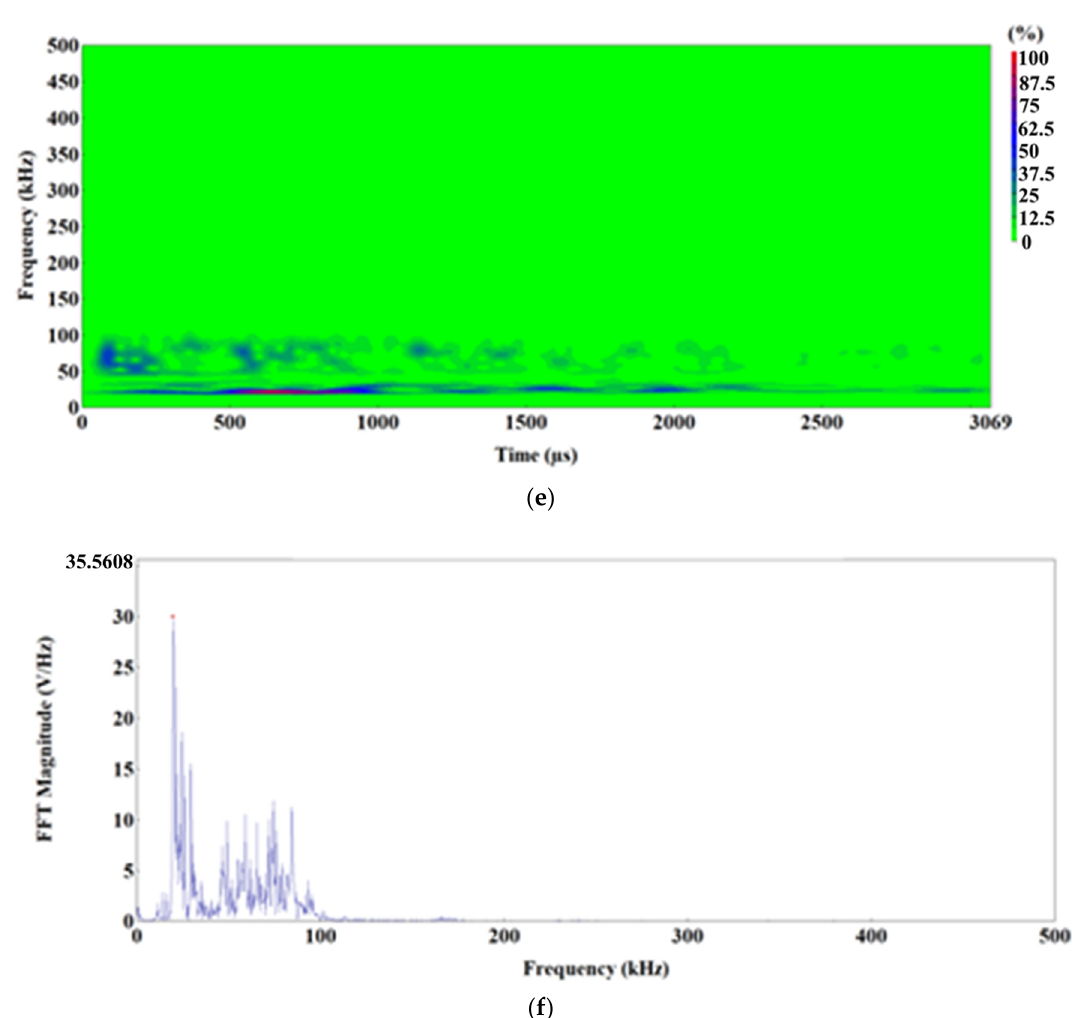
Figure 16. Time-frequency charts for the 1600–1700 s time range (distinct neck formation in the specimen): ( a , d ) Waveform Time Domain graphs, ( b , e )Waveform Continuous Wavelet graphs, ( c , f ) FFT Magnitude graphs.